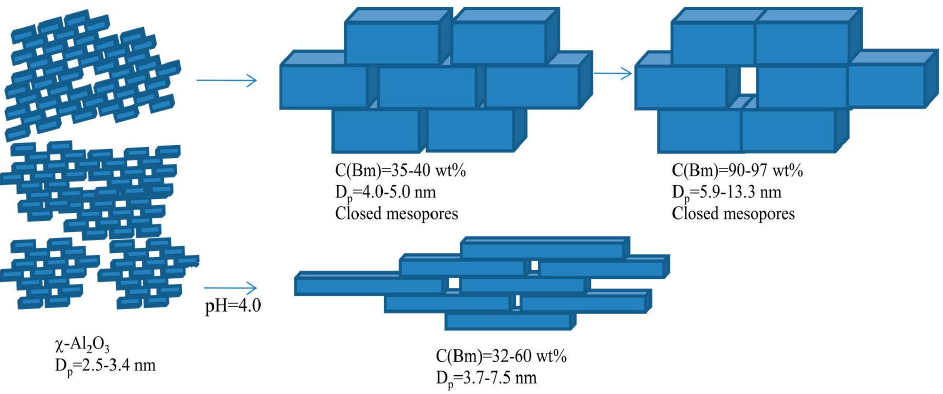
Figure 7. Formation of mesopores in the χ‐ Al 2 O 3 HTT products.